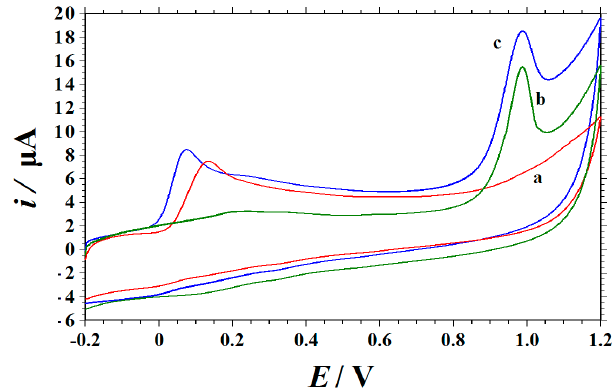
Figure 7. Cyclic voltammograms of 1.0 mM of AA ( a ), 10 µ M of RhB ( b ), the mixed solution of 1.0 mM of AA and 10 μ M of RhB on a Cu 2 O NPs ‒ ERGO/GCE in a 0.15 M HAc–NaAc buffer (pH 6.6) ( c ), with scan rate as 0.1 V s − 1 .